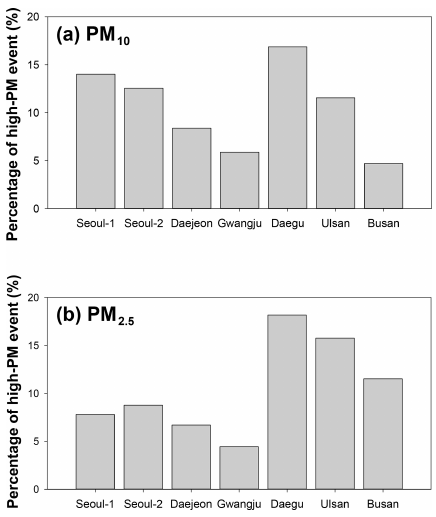
Figure 8. Percentage (%) of high-particulate-matter episodes in the training data